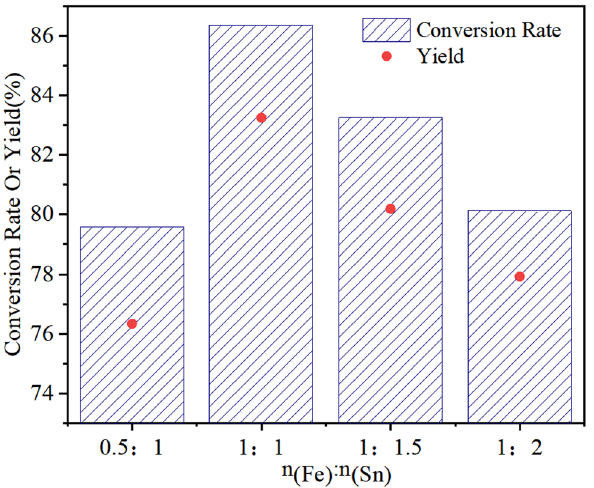
Figure 5: E ff ect of the metal ratio on the catalytic performance of Fe – Sn –